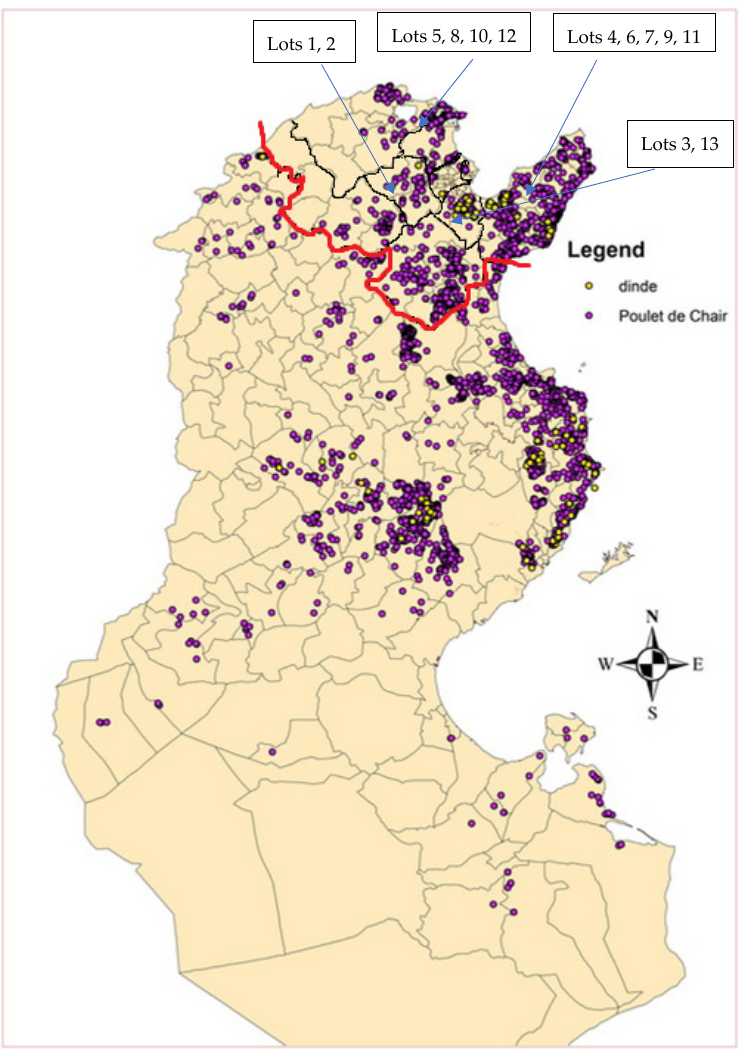
Figure 1. A map of Tunisia showing the location of broiler and turkey farms. Chickens sampled in this study came from farms located in the area bounded by the red line. Source: census report of poultry farms in Tunisia (2015–2016) by General Direction of Veterinary Services (DGSV).